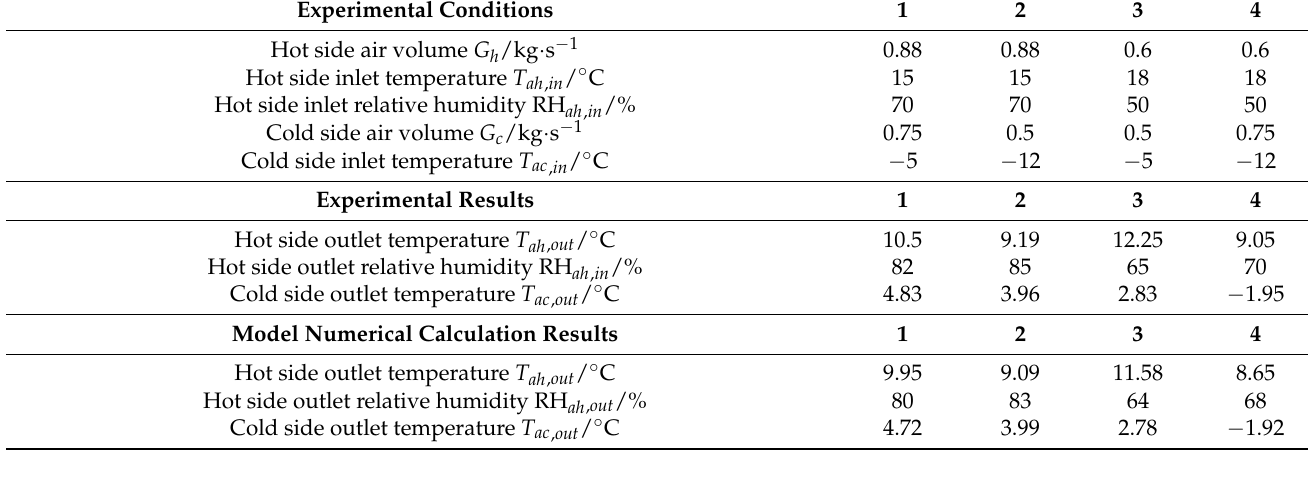
Table 3. Comparison and error of heat transfer experiment and numerical simulation data of heat pipe.